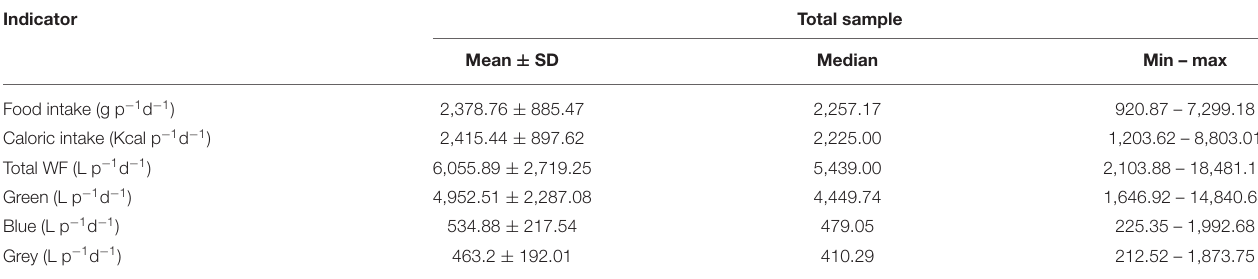
TABLE 3 | Dietary and caloric intake and its water footprint (WF).